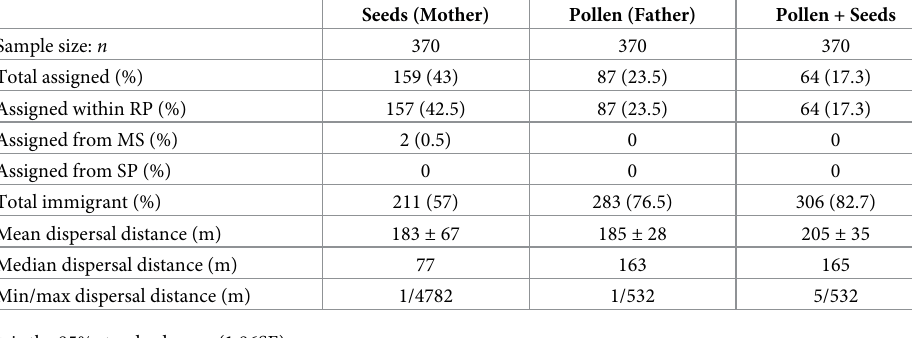
Table 2. Results of parentage analysis for individuals of the regenerant population (father or pollen parent; mother or seed parent) for Astronium fraxinifolium . Seeds (Mother) Pollen (Father) Pollen +